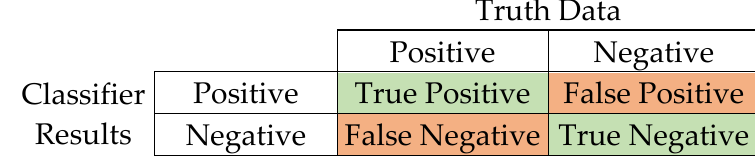
Figure 10. Confusion